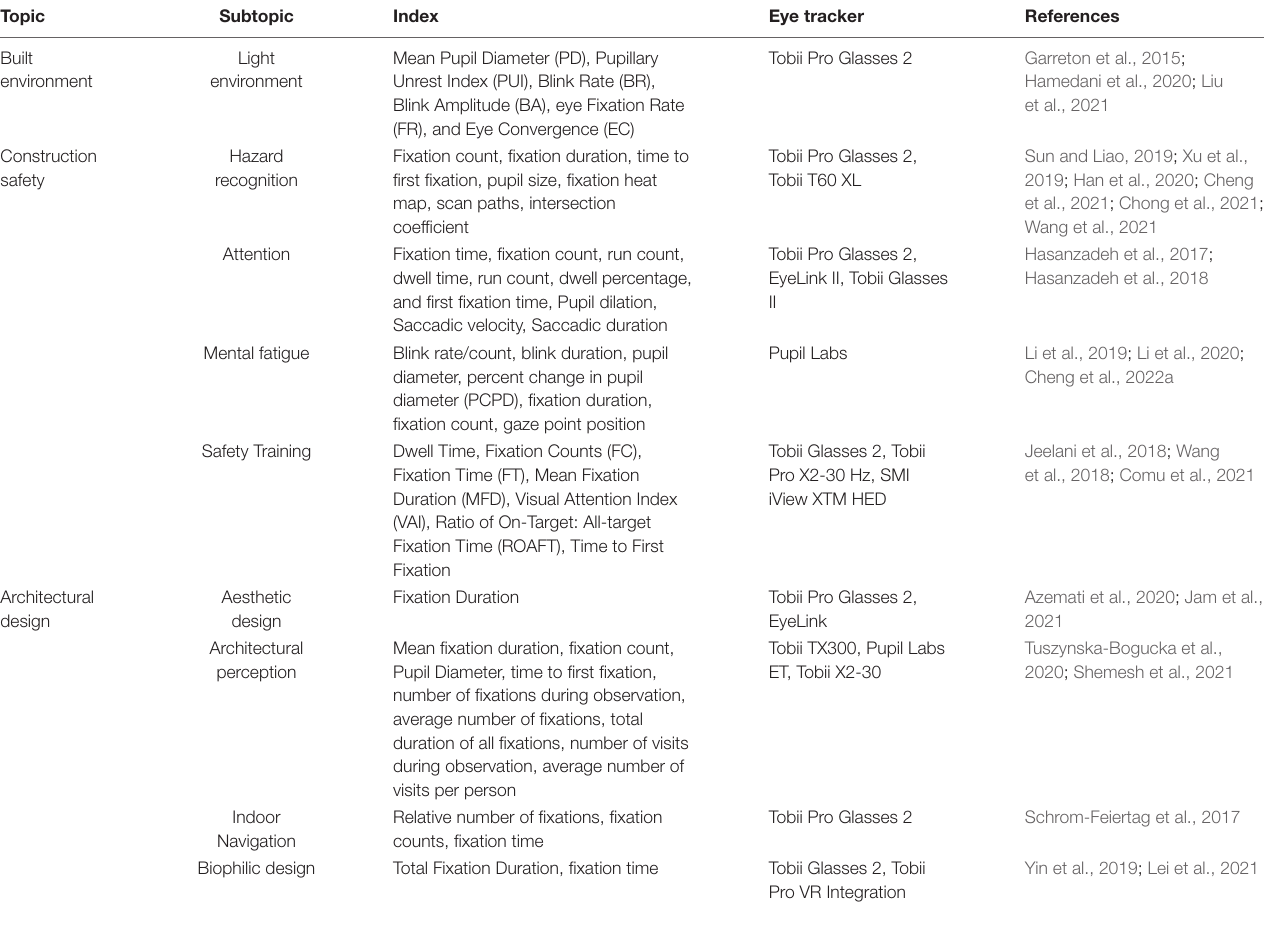
TABLE 3 | Research summary of ET applications in building